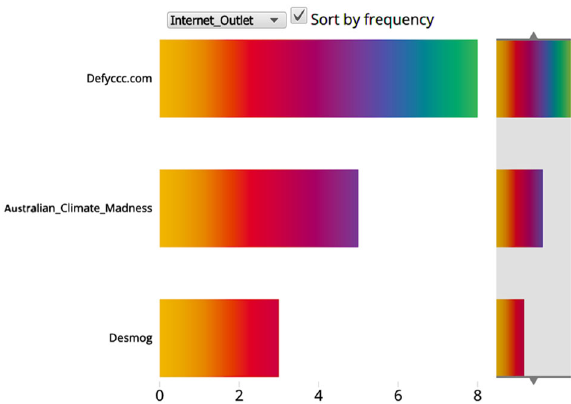
Fig. 4 Metafacet visualization for a concordance featuring dogma in CSBC (16 lines), fi ltered by Internet outlet and sorted